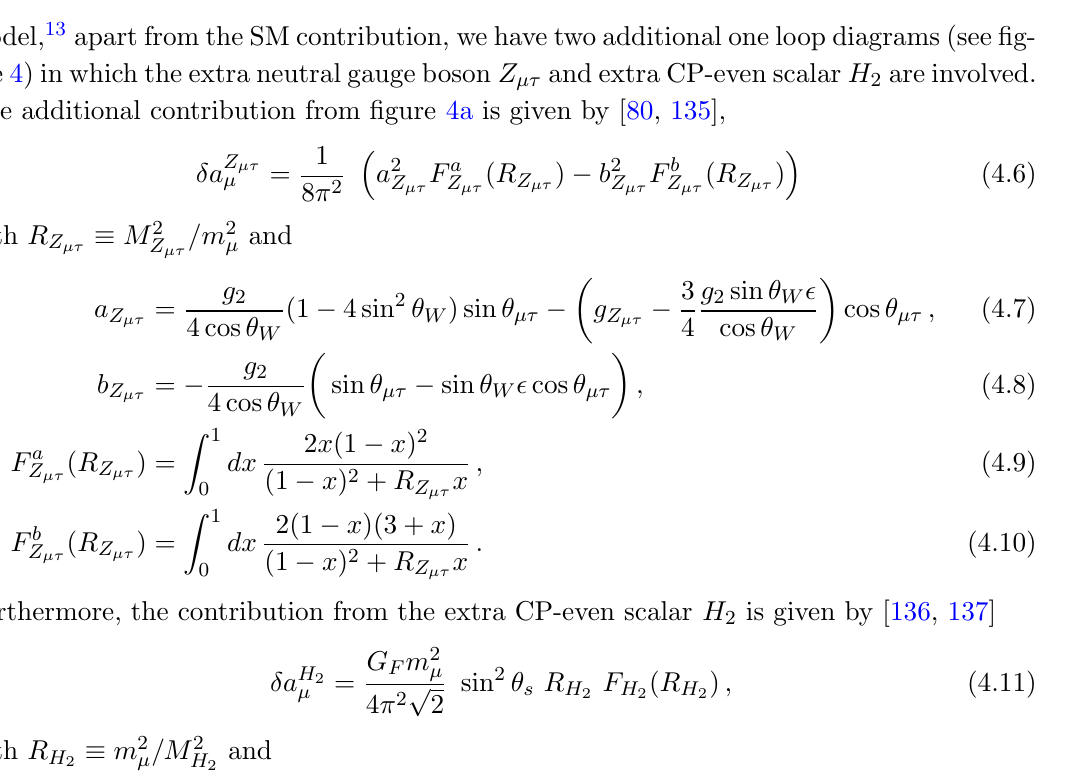
2) (cid:22) in addition to the SM. (cid:0)